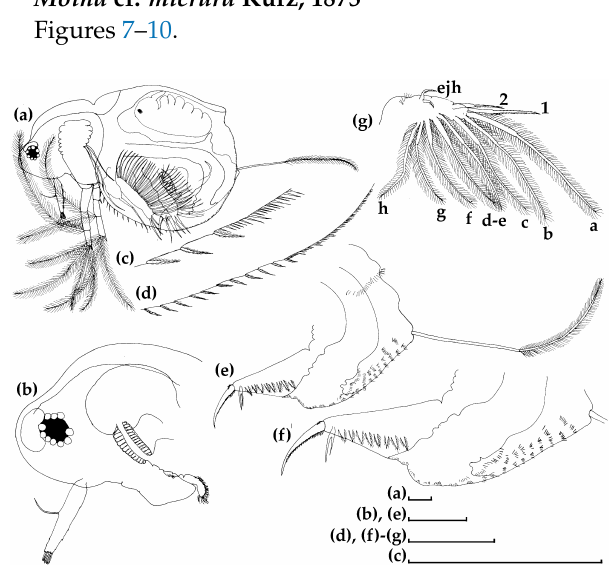
Figure 7. Moina cf. micrura , an adult parthenogenetic female from Masfoot Dam 1, United Arab Emirates. ( a ) Female, lateral view; ( b ) head; ( c , d ), armature of posteroventral portion of valve, inner view; ( e , f ), postabdomen; ( g ) thoracic limb I. All scale bars: 0.1 mm.